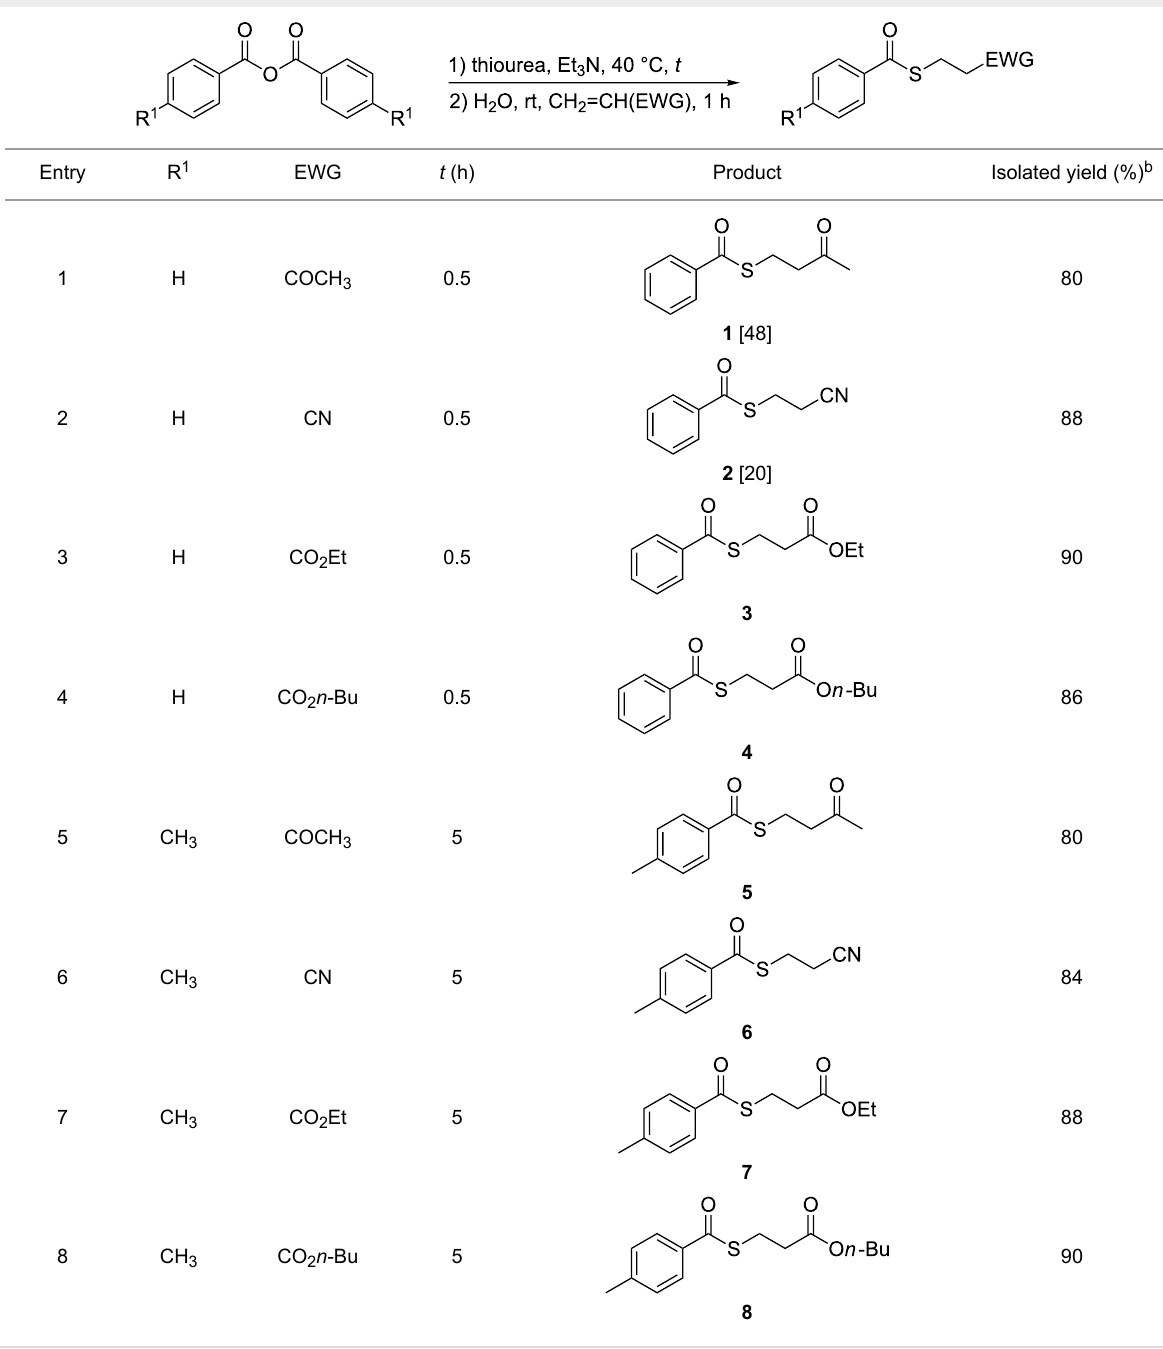
Table 1: One-pot synthesis of thioesters using benzoic anhydrides, thiourea and electron-deficient alkenes a